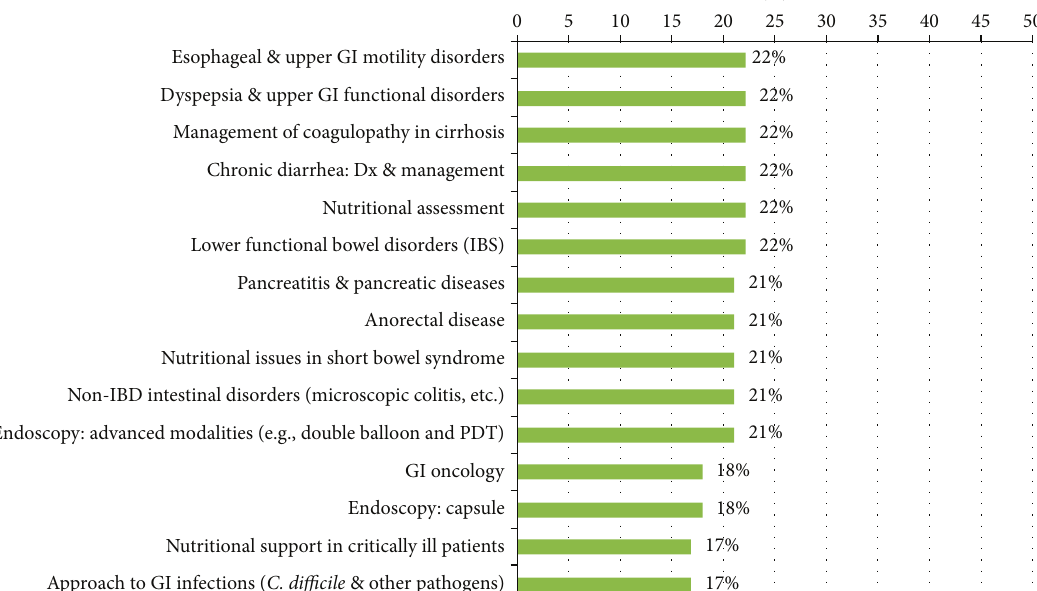
Most replies were from individuals in Ontario (40%), fol- lowed by Alberta (18%), British Columbia (16%), and Quebec (10%). Responses were distributed roughly in proportion to provincial